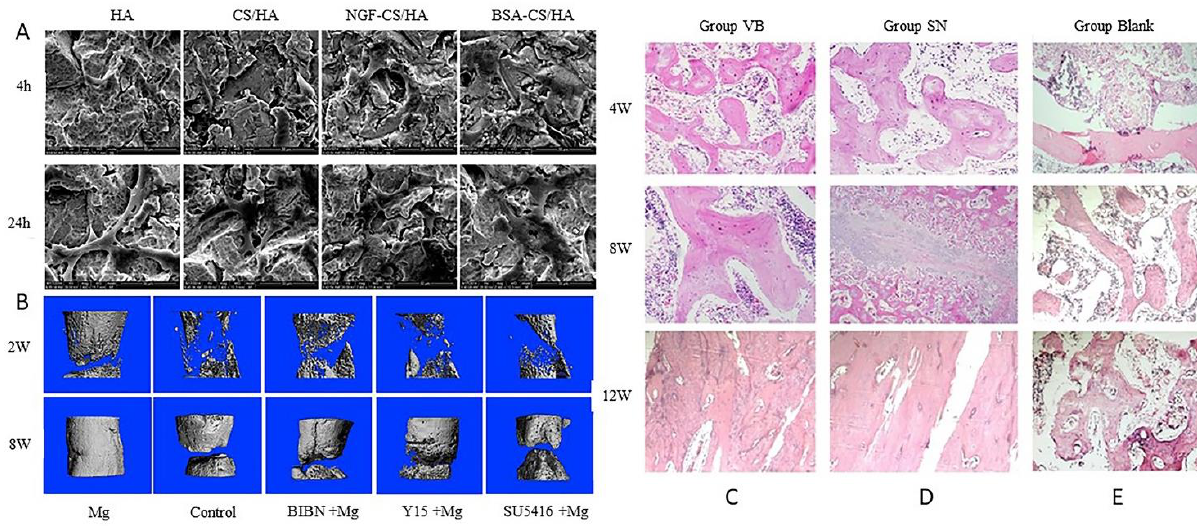
Figure 3. How the nervous system enhances the effect of osteogenesis, with examples from the litera- ture. ( A ): NGF-CS/HA composite coating has positive impact on the behavior of BMSCs. 4 and 24 h after BMSC culture, each group had excellent adhesion and was triangular or symmetrical; BMSCs have spread over the coating surface and displayed protruding pseudopodia [192]. Magnification, × 2400. ( B ): A 3D image of newly formed bone in the defect gap in the Mg group showed greater mineralization than that in the inhibitor/antagonist +Mg group at both 2 and 8 weeks as compared with the inhibitor/antagonist +Mg group [201]. ( C – E ): The formations of new bone in group VB ( C ) and group SN ( D ) were better than that in group Blank ( E ) and there was no obvious difference between VB and SN at 4, 8, and 12 weeks (HE × 100) [204]. Reprinted with permission from Ref. [192]. 2020, Elsevier; Ref. [201]. 2021, Elsevier